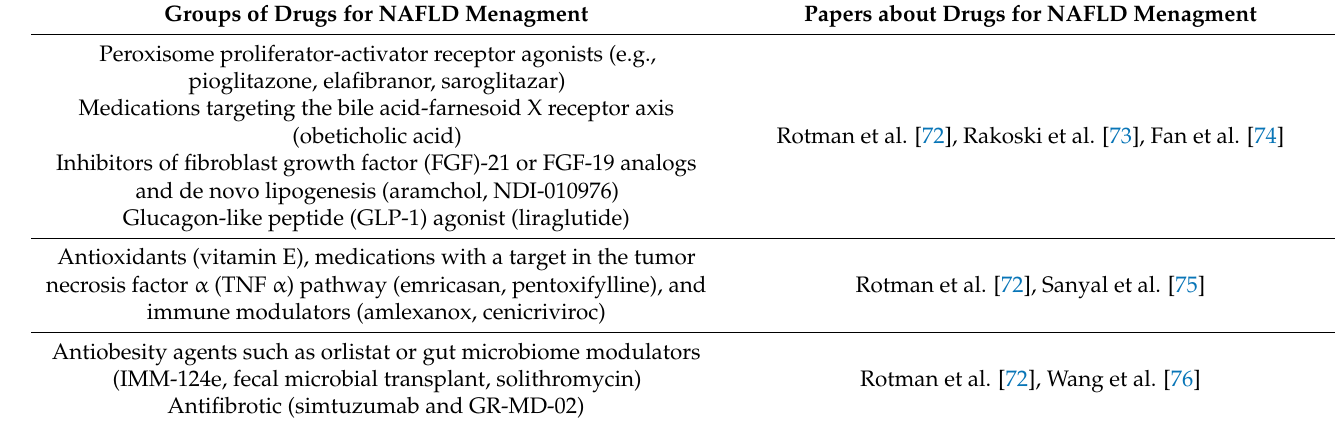
Table 3. The groups of drugs used in NAFLD